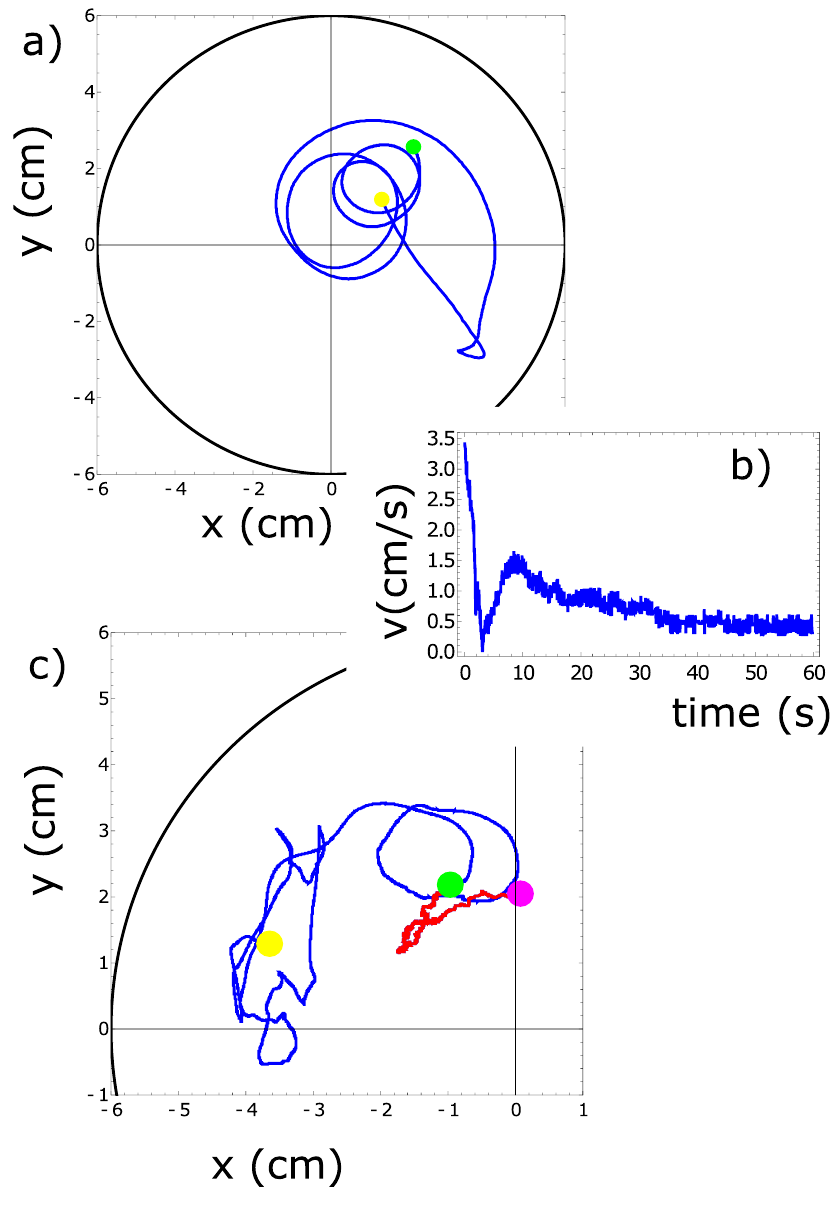
Figure 1. The motion of a 4 mm pill made of 90% by weight of camphene and 10% by weight of polypropylene observed at short and long times. ( a ) The trajectory of the first 60 s of motion after the pill was located on the water surface. The yellow disk marks the initial position of the pill, and the green one shows its location after 60 s. ( b ) The pill speed measured for the trajectory shown in ( a ). ( c ) The blue and red lines show the trajectory observed in the time intervals [66 min, 70 min] and [70 min, 79 min] after the pill was placed on the water surface, respectively. The yellow, green, and magenta disks mark the pill positions at t = 66,70, and 79